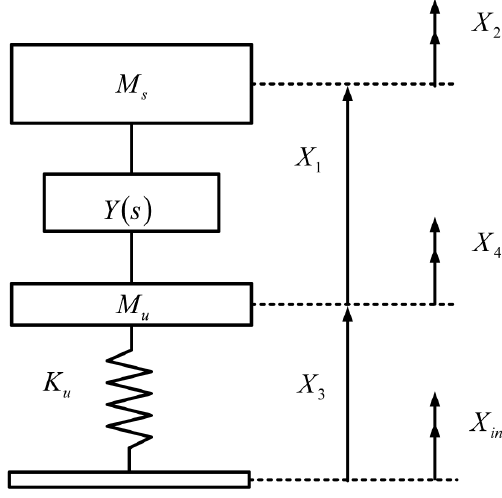
Fig. 1. A quarter-car model with a Passive